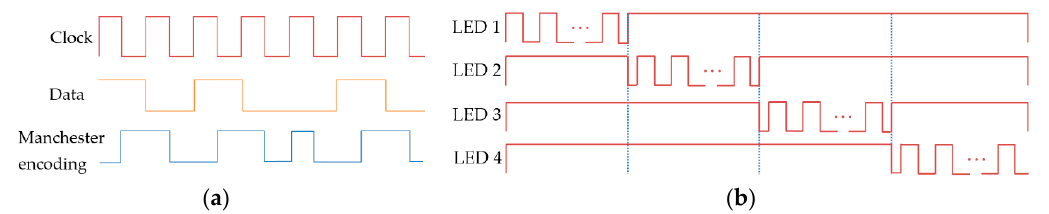
Figure 3. Design of prototype. ( a ) On-Off keying (OOK) modulation using Manchester encoding. ( b ) Time-division multiplexing (TDM) protocol.